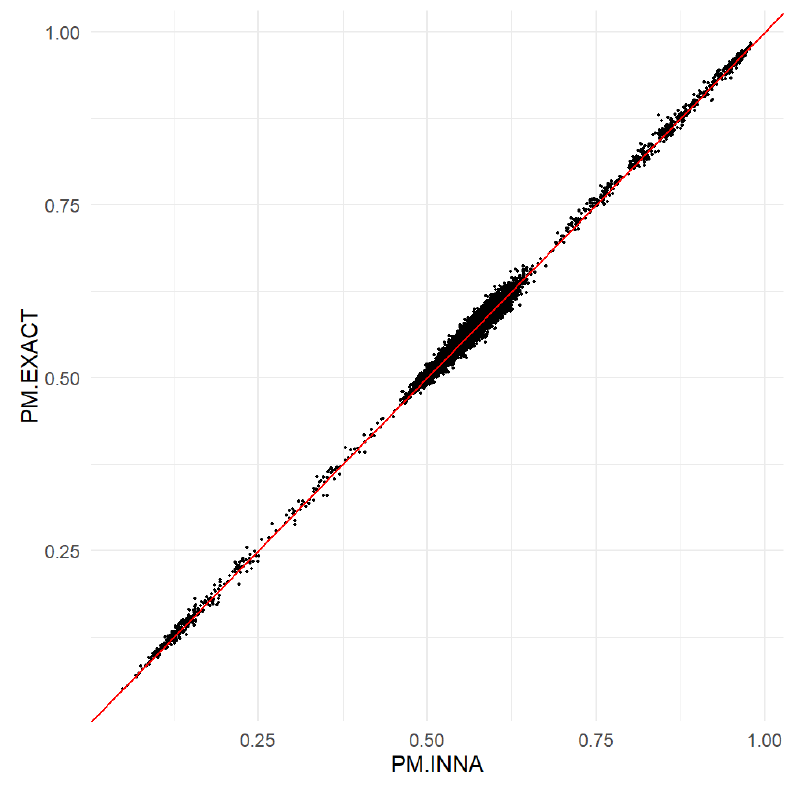
Figure 1. Comparison of the INNA method and the exact method using the PSDs of the household